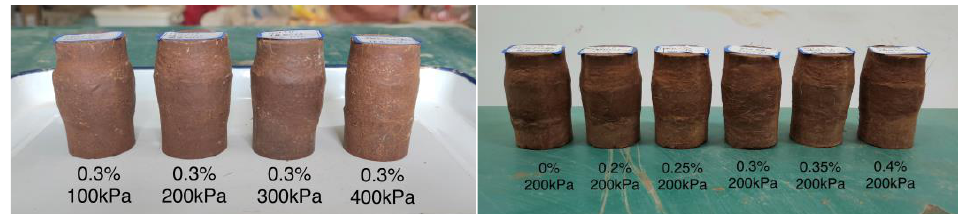
( b ) Figure 8. Variation in shear strength index with fiber content. ( a ) influence of fiber content on cohe- sion; ( b ) influence of fiber content on internal friction angle. 3.3. Failure Characteristics of Coir Fiber-Reinforced Soil The failure mode of the coir fiber-reinforced soil sample is shown in Figure 9. From the diagram, it can be seen that the failure mode of the sample was a mainly bulging fail- ure, that is, after the failure, the sample underwent lateral bulging, with large intermediate deformation, small ends, drum-shaped, and no obvious fracture surface. The deformation was gradual from the middle to the ends, and the shape was uniform. During the test, due to the friction between the two ends of the specimen and the upper and lower loading device, the restraint effect of the specimen from the two ends to the middle was gradually reduced, so the deformation characteristic of the middle was large, and that of the two